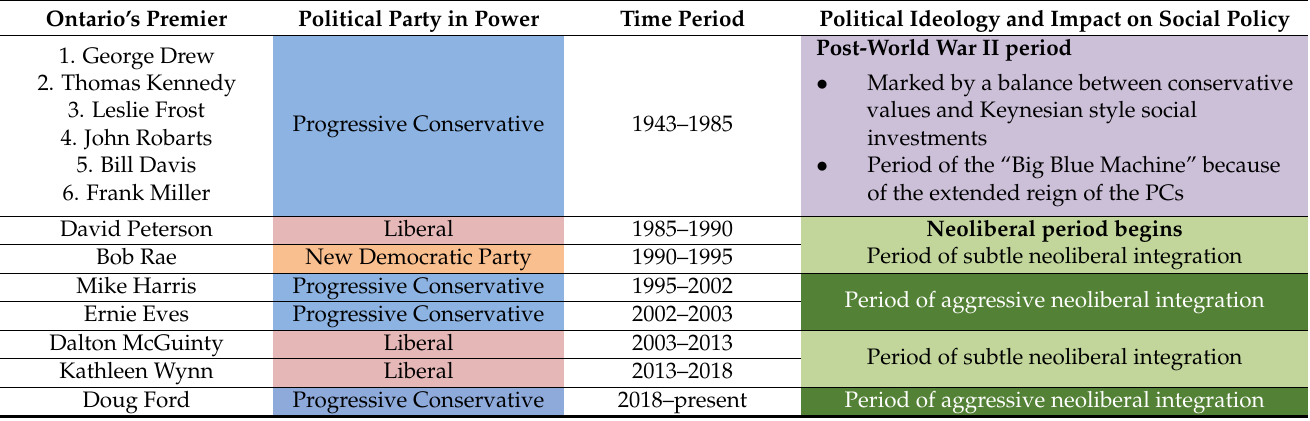
Table 2. Summary of Ontario’s Premiers in power at the provincial level during the Keynesian period to current neoliberal times (Albert and Kirwin 2006; Harvey 2005; Parliament of Canada